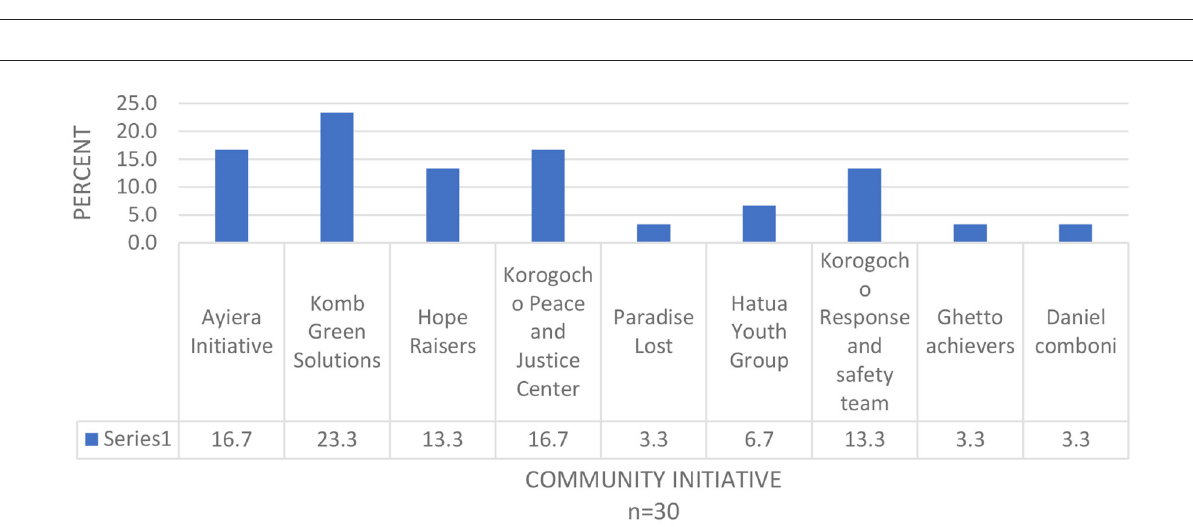
FIGURE3 Community based initiatives that are working toward disaster risk preparedness and responses. Source: Muchiri and Opiyo